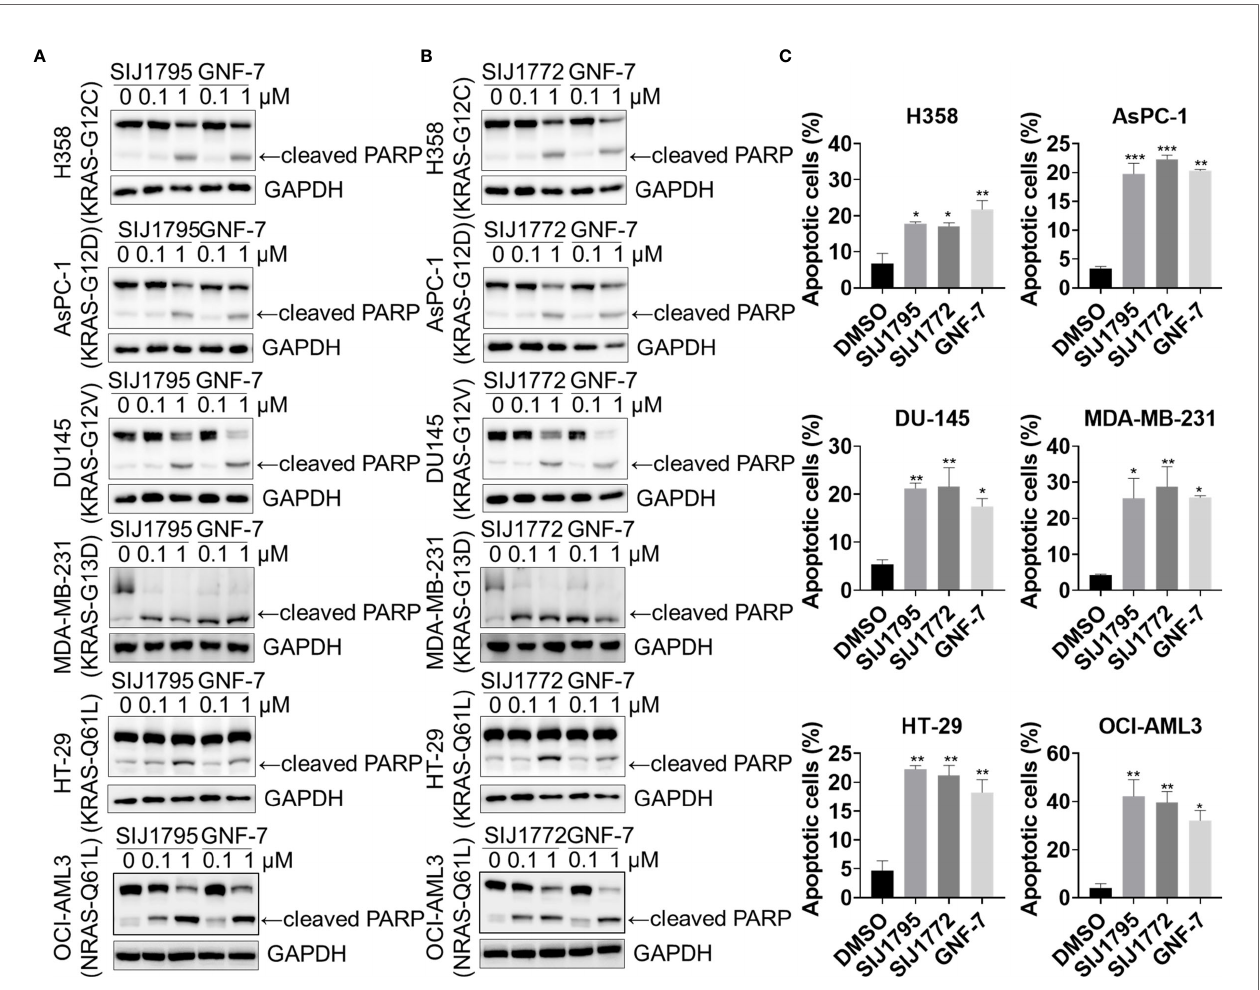
FIGURE 4 | The effects of (A) SIJ1795 and (B) SIJ1772 on apoptosis induction in cancer cells harboring mtRAS. Cells were treated with 0.1 and 1 m M of SIJ1795 SIJ1772, and GNF-7 for 24 h. Western blot analysis was conducted to evaluate the cleaved PARP and level. GAPDH was used as a loading control. (C) Apoptotic cell population (annexin V-positive) was determined by fl ow cytometry analysis (n = 3). Cells were treated with 1 m M of indicated compounds for 24 h. Statistical signi fi cance was determined using a one-way ANOVA analysis (*p < 0.05, **p < 0.01, ***p <